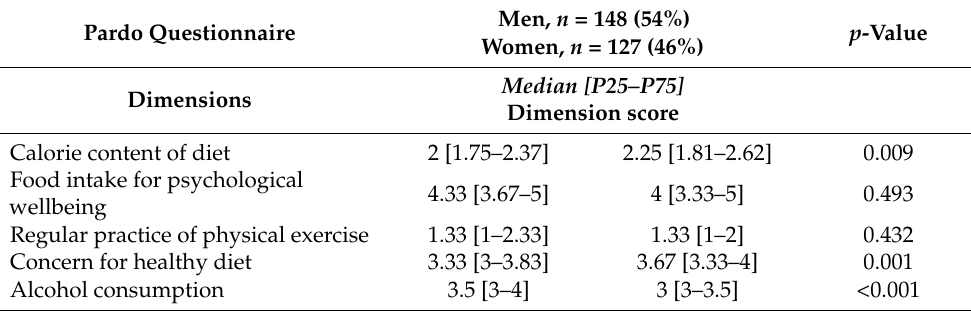
Table 4. Results of PARDO questionnaire dimensions on life habits related to overweight before hospital